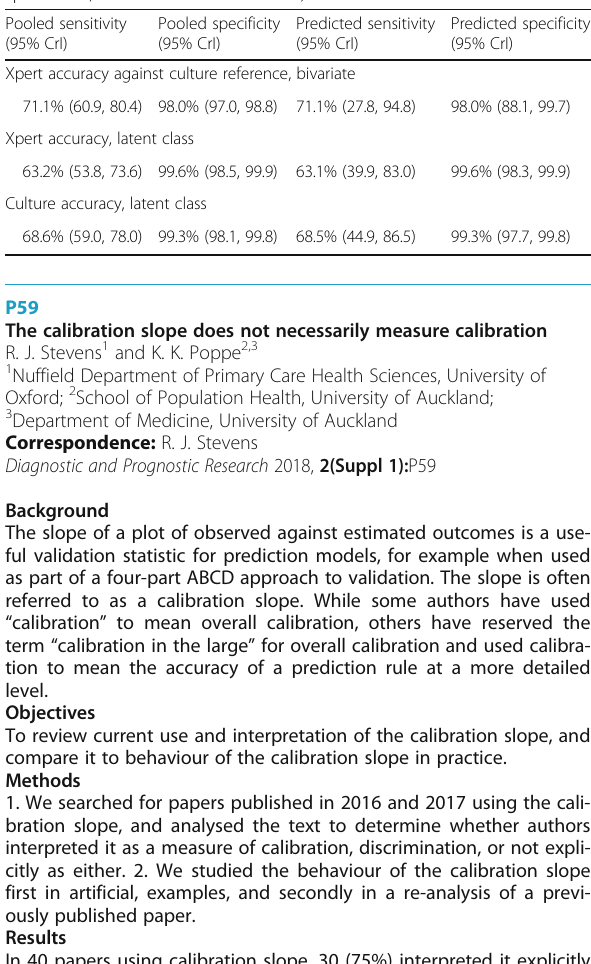
Table 1 (abstract P58). Xpert for TB meningitis, 29 studies (3774 specimens, 433 culture-confirmed